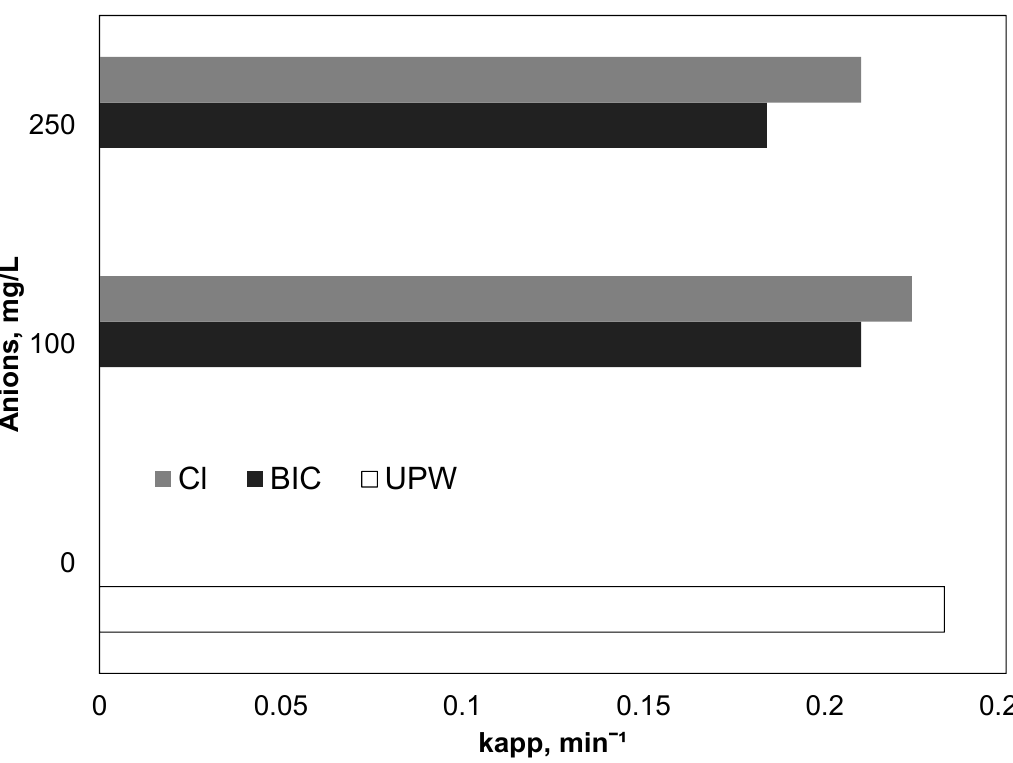
Figure 5. Effect of inorganic ions on the degradation of PIR, [PIR] = 500 µ g/L, [Fe 2+ ] = 2 mg/L, [SPS] = 20 mg/L, ultrapure water and inherent pH.